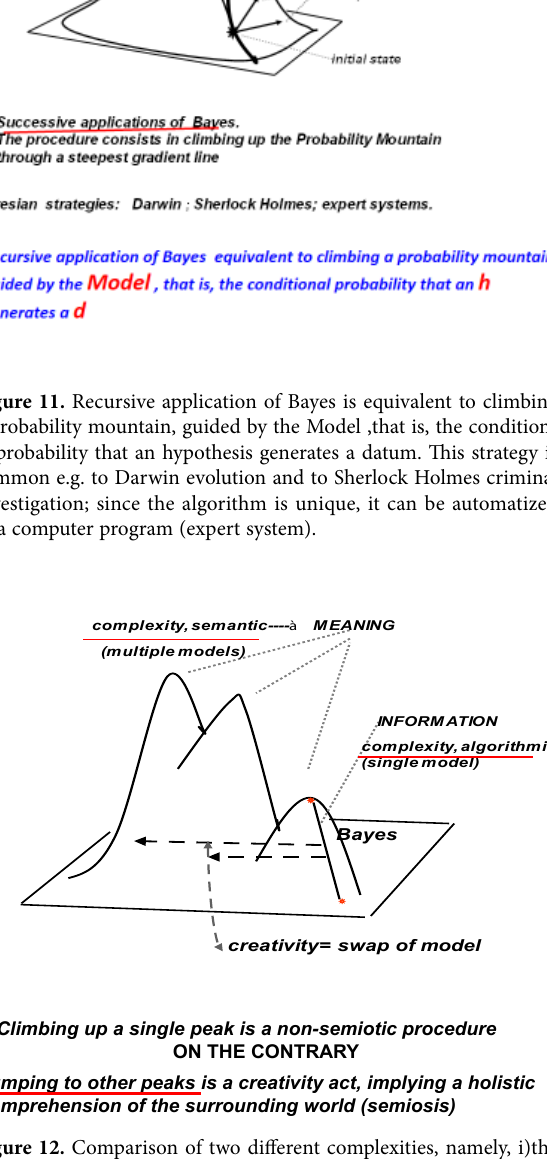
Jumping to other peaks is a creativity act, implying a holistic comprehension of the surrounding world Figure 12. Comparison of two different complexities, namely, i)the algorithmic C. , corresponding to the bit length of the program that enables the expert system to a recursive Bayes; and ii)semantic C., corresponding to the occurrence of different models.